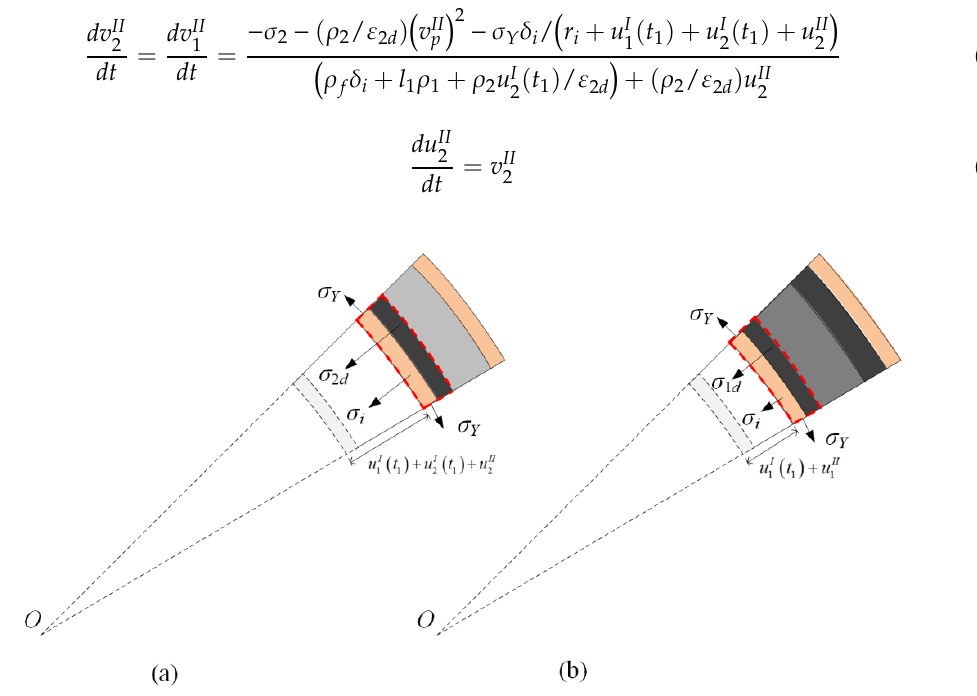
Figure 7. Stress analysis for a cylinder with a negative-gradient core in stage II. ( a ) Scenario 1, and ( b ) Scenario 2.